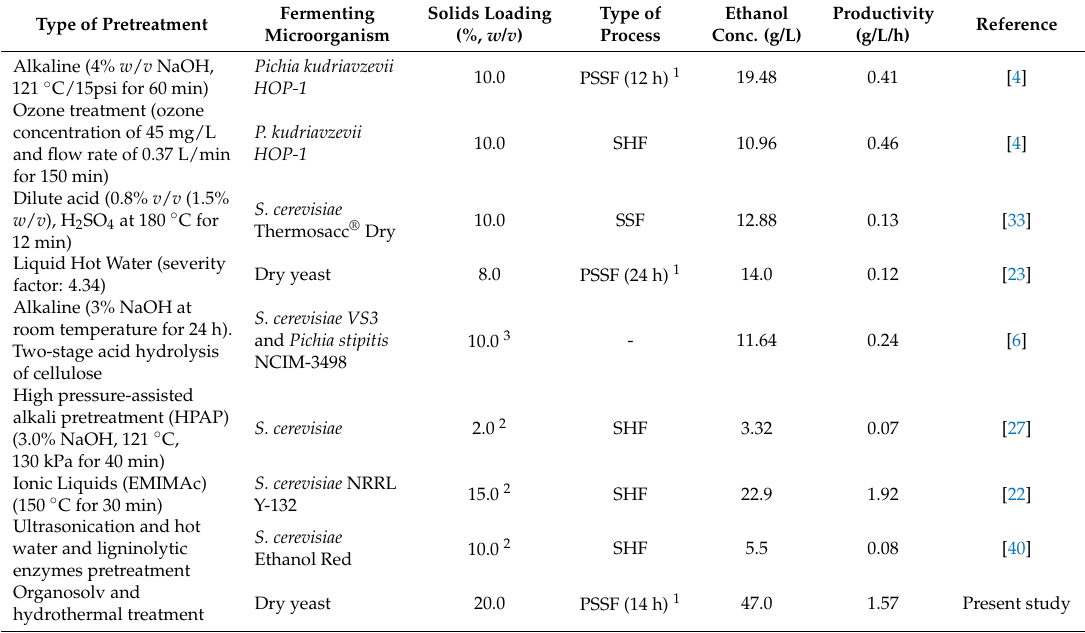
Table 3. Comparison of different processes for ethanol production from pretreated